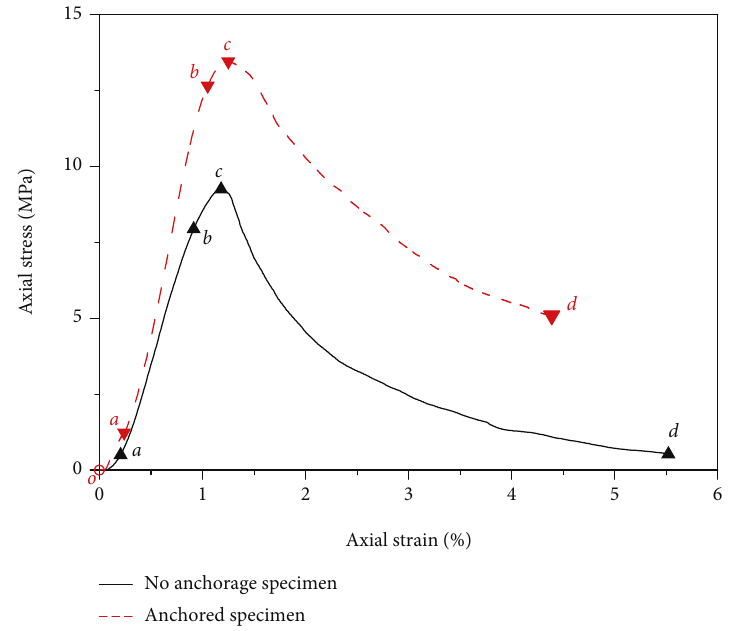
Figure 3: Axial stress vs. axial strain curve of rock mass specimen under uniaxial compression.